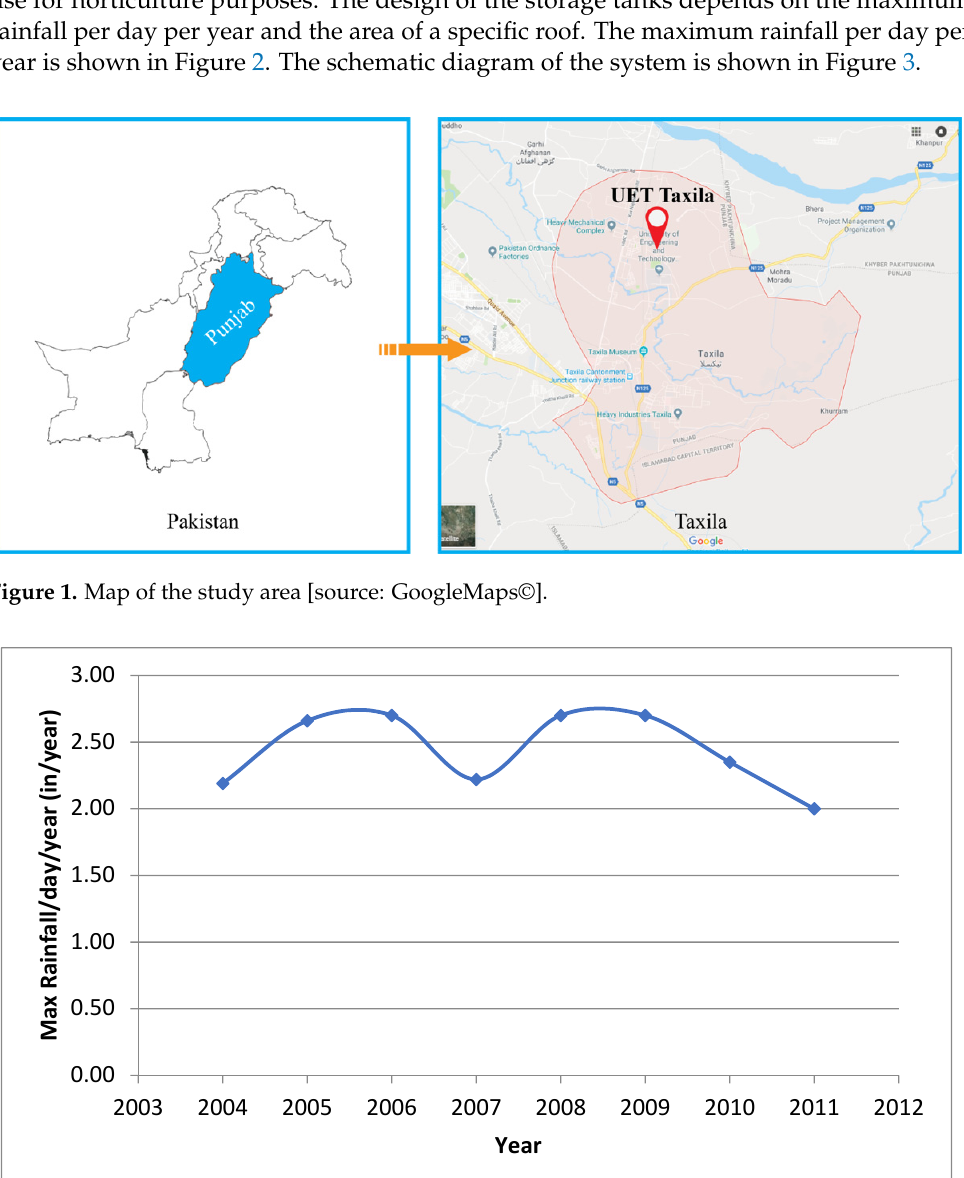
Figure 3. Schematic diagram of a rooftop harvesting system. The groundwater is depleting every year due to land-use change and climatic varia- tions. Hence there is a need to design a rainfall harvesting system in order to raise ground- water by installing an artificial groundwater recharge system. There are twenty depres- sion points in the study area where water accumulates during rainfall. These points are observed by field visits after every rainfall event during the past few months as shown in Figure 4.